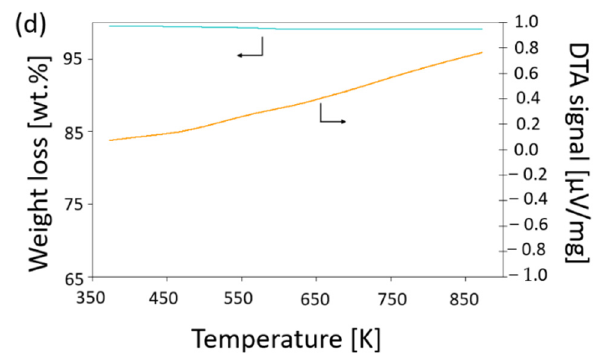
Figure 1. TG and DTA curves obtained for ( a ) MgO-473, ( b ) MgO-573, ( c ) MgO-673 and ( d ) MgO-873.